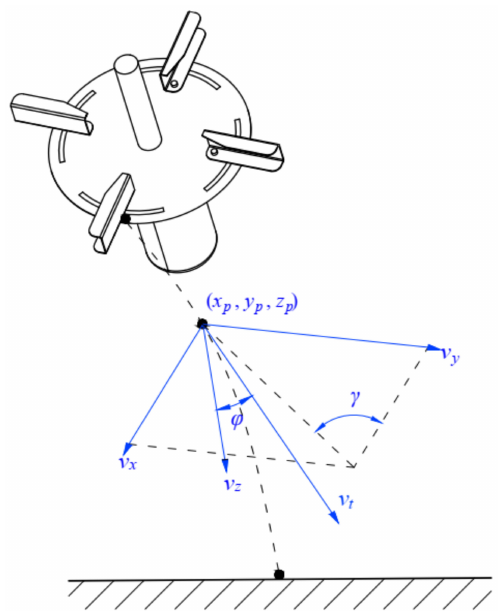
Figure 6. Kinematic model of fertilizer particle after leaving the